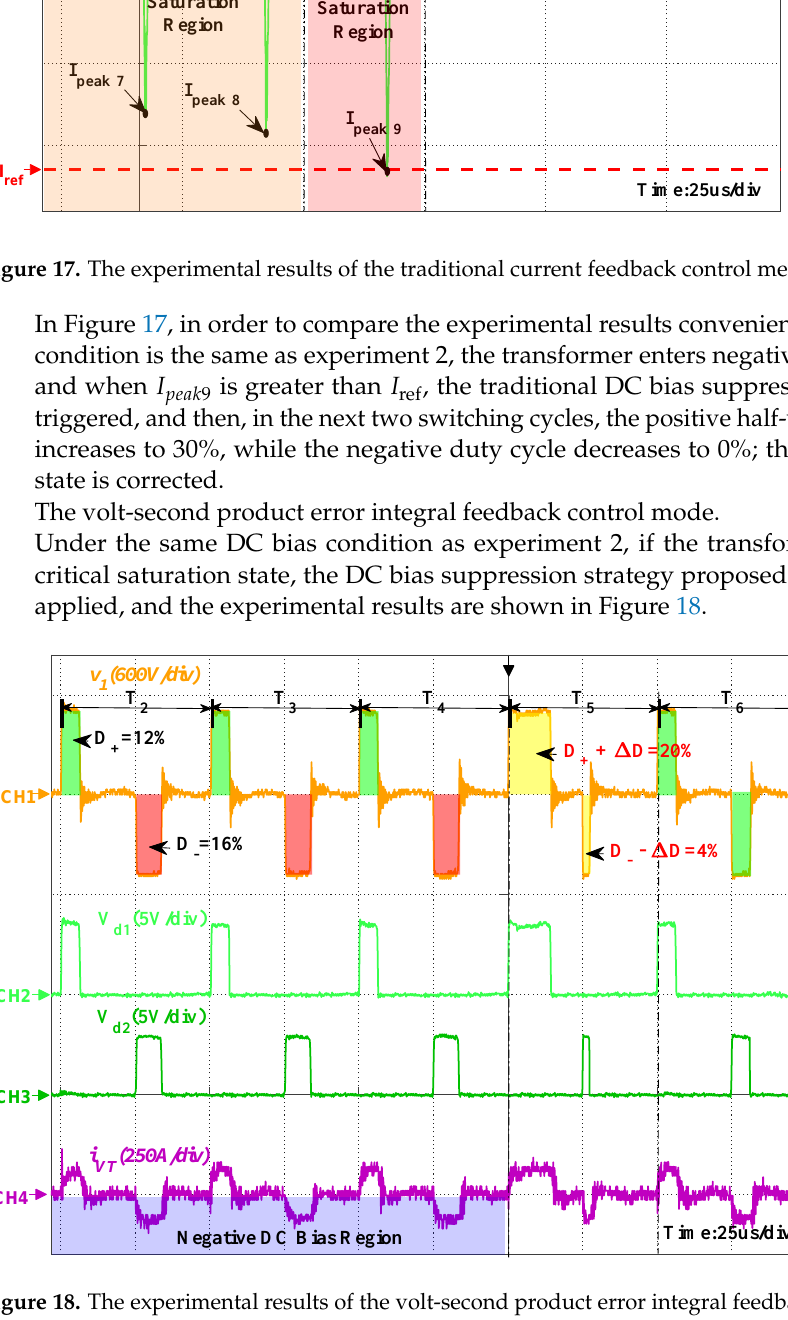
Figure 18. The experimental results of the volt-second product error integral feedback control